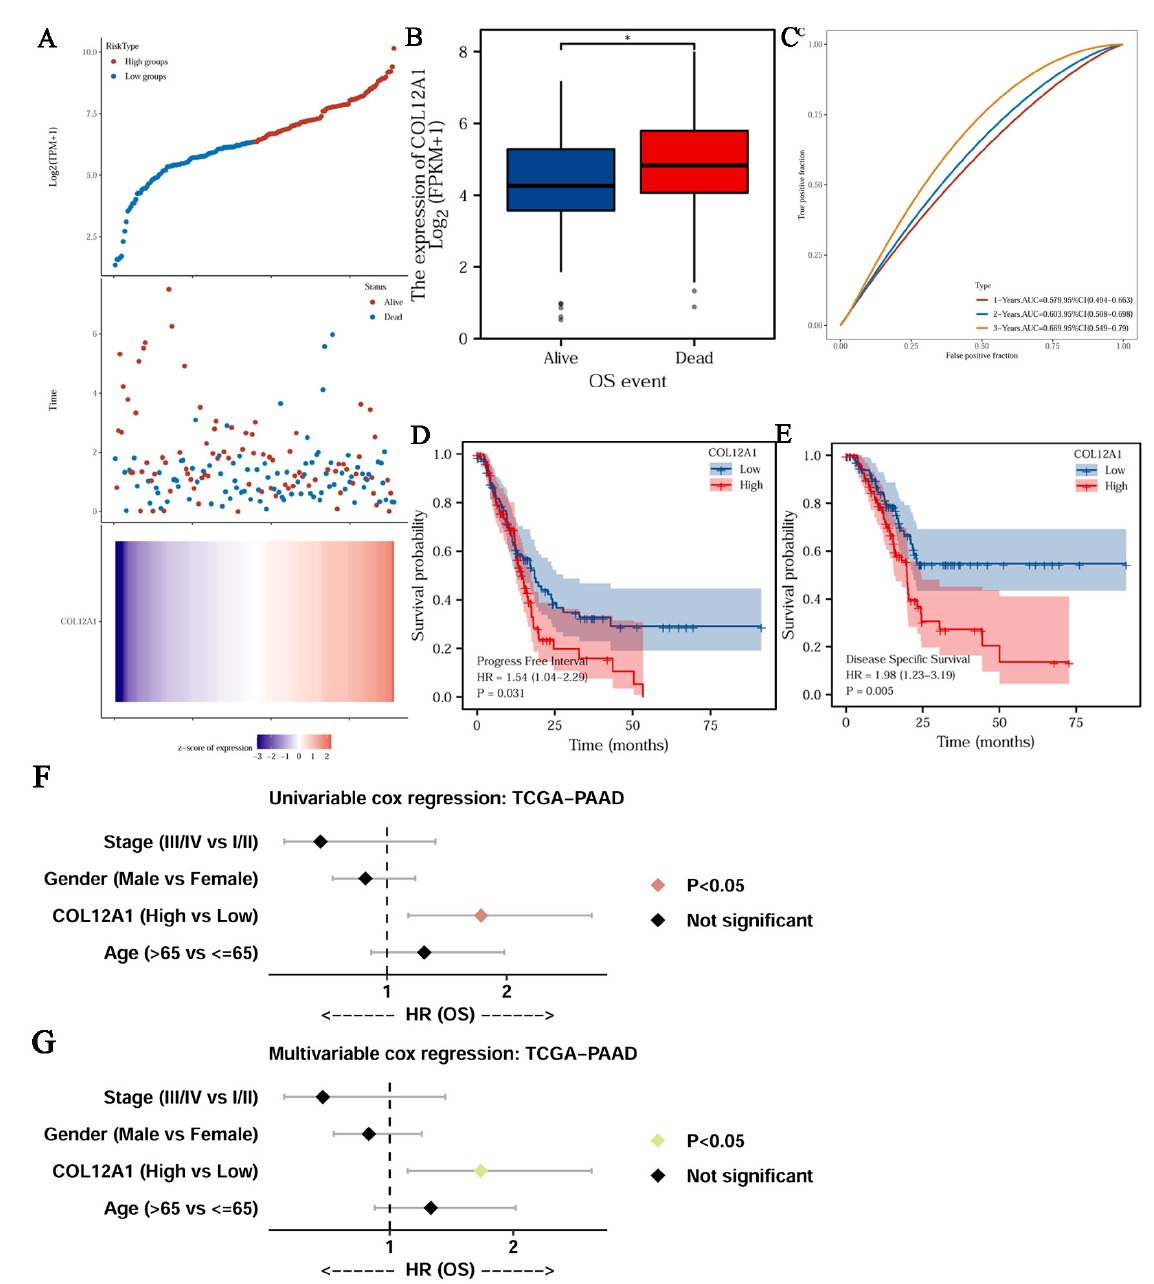
Figure 5. The clinical prognosis of COL12A1 in pancreatic cancer. ( A ) The dead and alive pa- tients in low-COL12A1 expression people and high-COL12A1 expression people. ( B ) OS event in low-COL12A1 expression people and high-COL12A1 expression people. ( C ) Receiver operating characteristic (ROC) curve analysis and area under the curve (AUC) statistics were implemented to evaluate the capacity of COL12A1 to identify the prognosis in pancreatic cancer. ( D ) The progression- free interval (PFI) curve of COL12A1 in pancreatic cancer ( p < 0.05). ( E ) Disease-specific survival (DSS) curve of COL12A1 in pancreatic cancer ( p < 0.05). ( F ) Univariable analysis for the OS analysis in pancreatic cancer in the TCGA dataset. ( G ) Multivariate analysis for the OS analysis in pancreatic cancer analysis in the TCGA dataset. *, p <